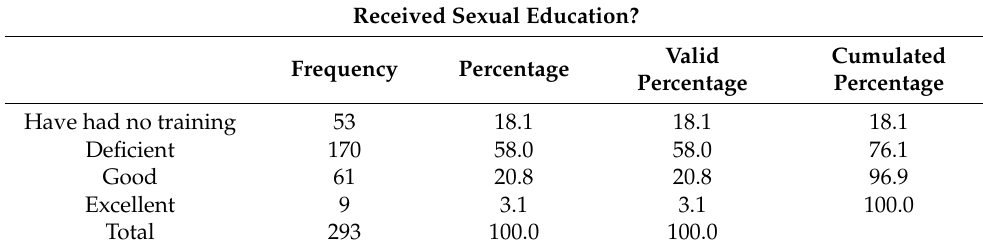
Table 1. Descriptive statistics on the degree of sexual education received.